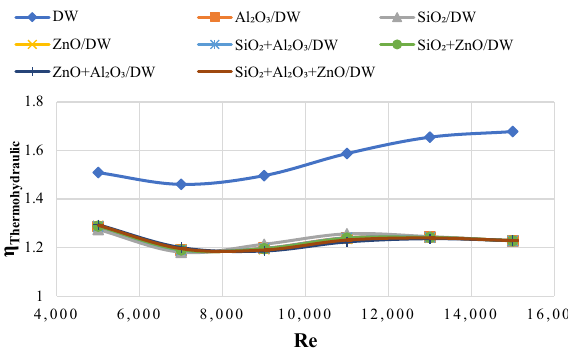
Figure 8: Thermohydraulic performance of plain and twisted pipes using DW, single, hybrid, and ternary nano fl uids at